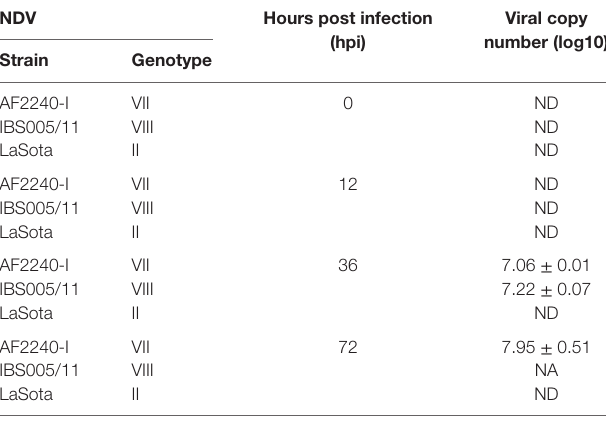
TaBle 2 | Detection of Newcastle disease virus (NDV) copy number from CD3 − /28-4 + enriched IEL-NK cells. nDV hours post infection